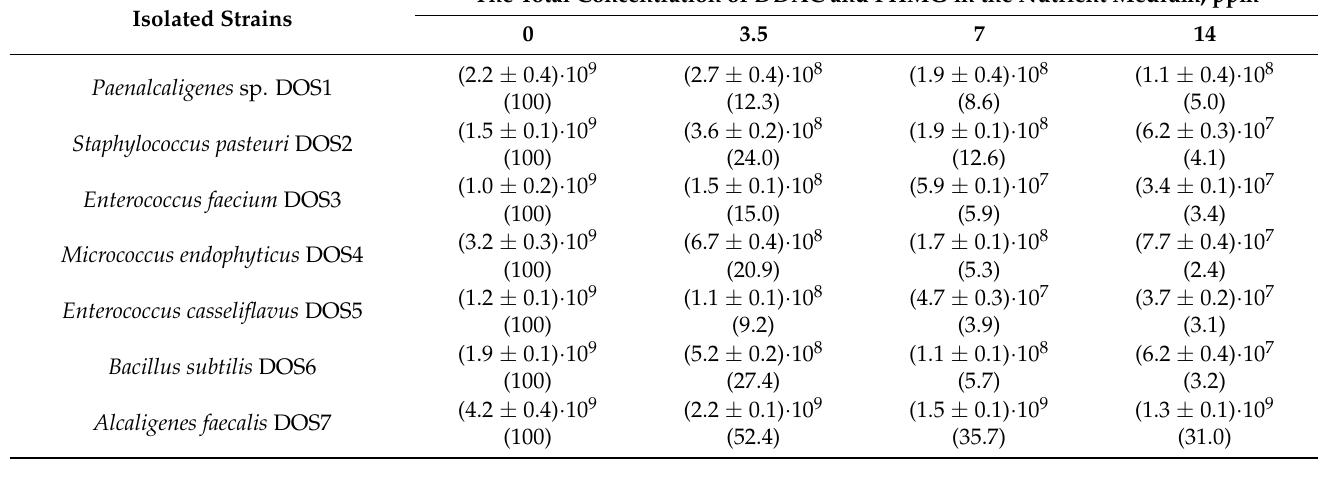
Table 3. The number of viable cells grown in the presence of biocide “Latrina” (% of the cell number in the control population without biocide).